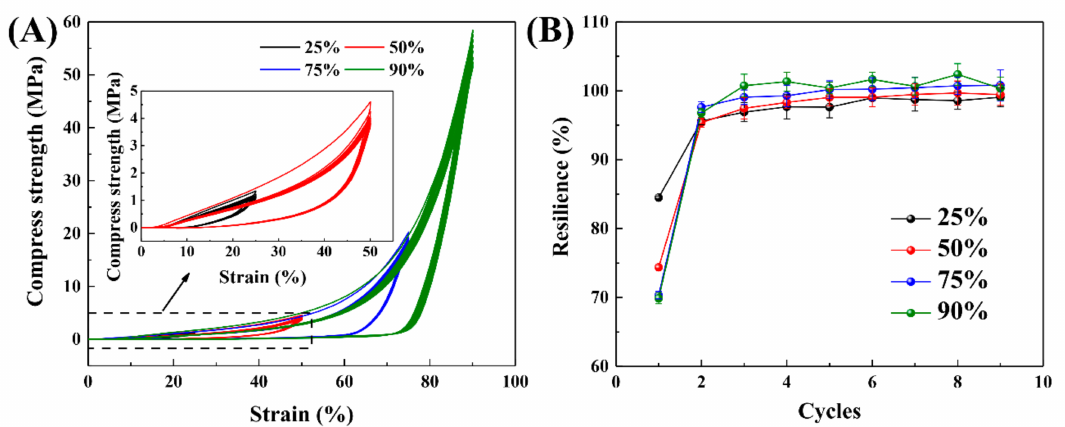
Figure 5. ( A ) Loading–unloading curves of GEL-0.5 during successive compression cycles at di ff erent strains; ( B ) the calculated resilience of GEL-0.5 during the cyclic tensile